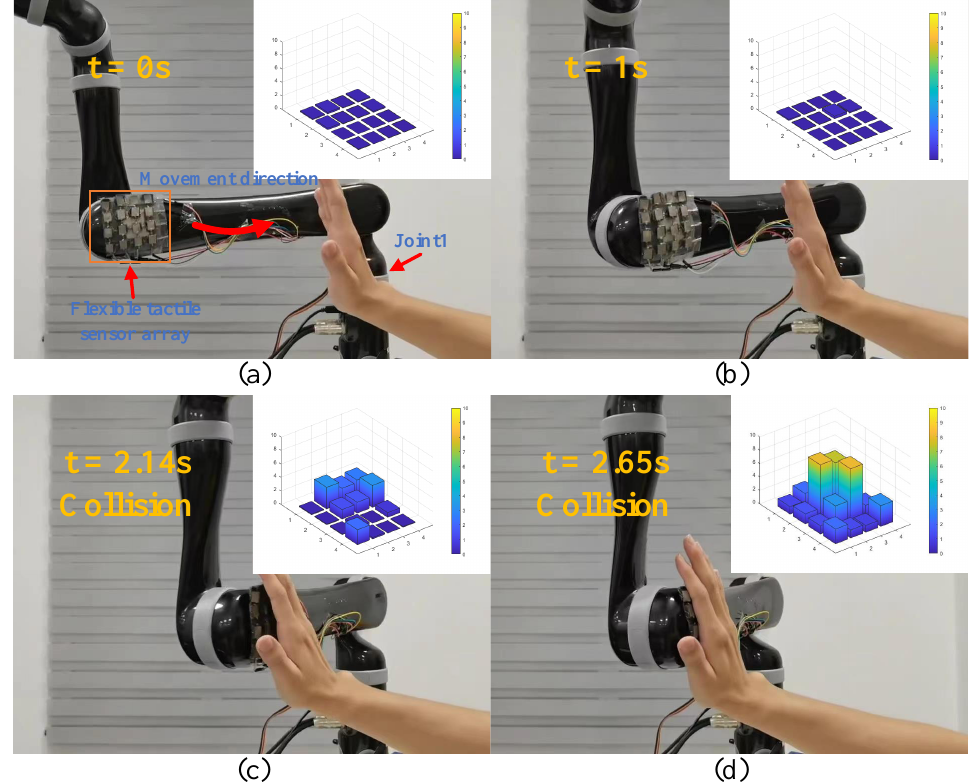
Figure 10. The safe human-robot interaction experiments. ( a ) the initial scene of experiments. (t = 0 s) ( b ) the robot moves without touching (t = 1 s) ( c ) the speed of the robot arm starts to decrease (t = 2.14 s) ( d ) the robot arm stops moving. (t = 2.65